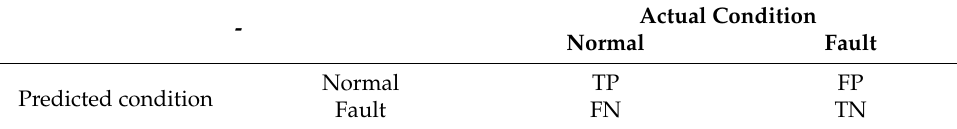
Actual Condition